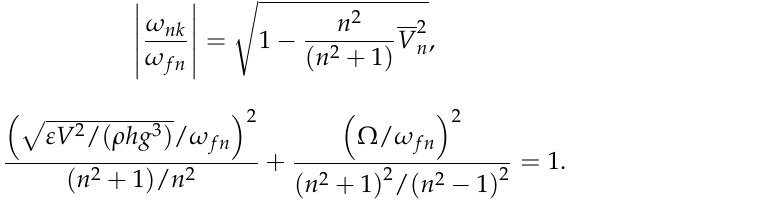
(cid:3627) , and the potential difference between the rotating ring and fixed electrode is also normalized to be dimensionless potential difference, (cid:1848)(cid:3364) (cid:3041) . Two frequency curves, one dashed curve and one solid curve, are plotted for different value of (cid:1848)(cid:3364) (cid:3041) , the dashed curve is for (cid:2033) (cid:3041)(cid:2869) and the solid curve for (cid:2033) (cid:3041)(cid:2870) . The dashed and solid curves for every value of (cid:1848)(cid:3364) (cid:3041) have two intersections, one intersects at the ordinate and its value is given by